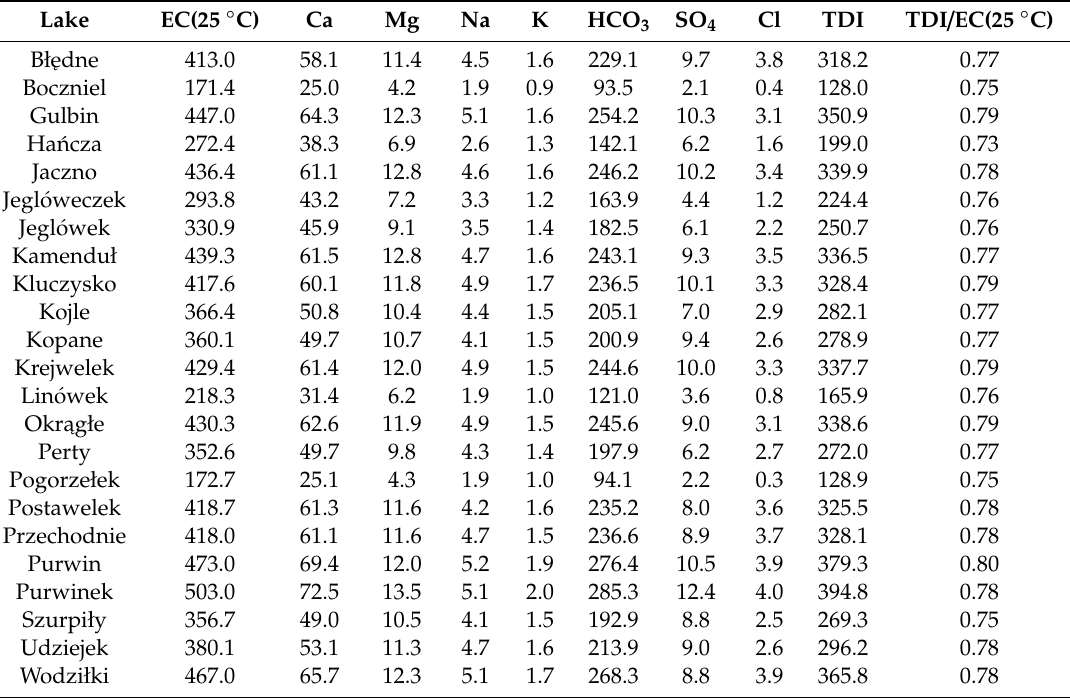
Table 3. The average chemical composition of surface water of the Suvalkian lakes examined in the years 2012–2014 (spring and summer). Ion concentrations and Total Dissolved Ions, TDI, are given in mg L − 1 , and conductivity, EC(25 ◦ C), in µ S cm − 1